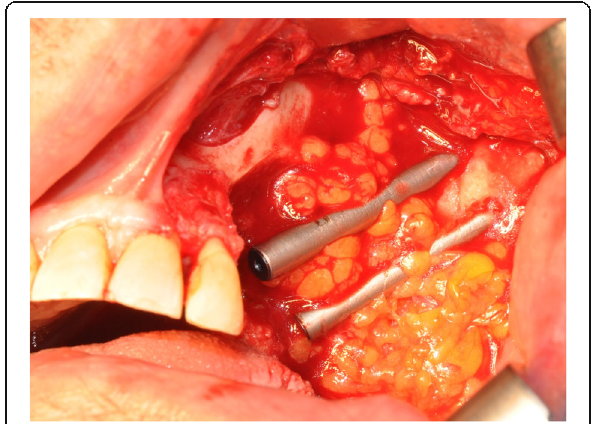
Fig. 2 Pt no. 1. The buccal fat pad harvested and moved in order to repair the oroantral communication and to wrap the zygomatic implants